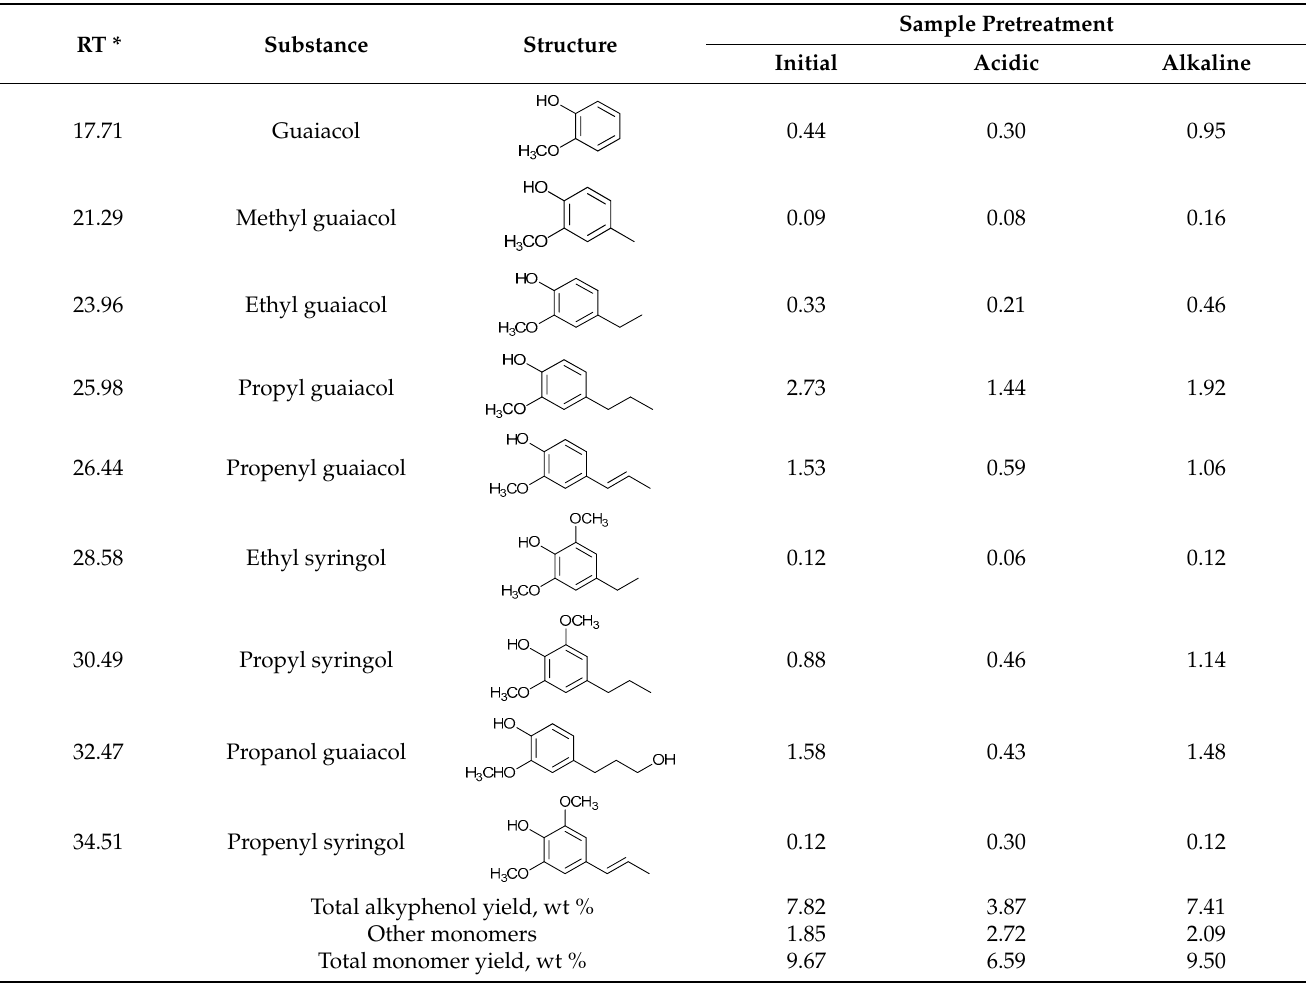
Figure 8. Effect of the stirring rate and catalyst particle size on the yield of main monomeric com- pounds. Table 8. Effect of pretreatments of flax shives on the yield of monomeric compounds in the followed fractionation process (225 ◦ C, 3 h, 10NiS450).